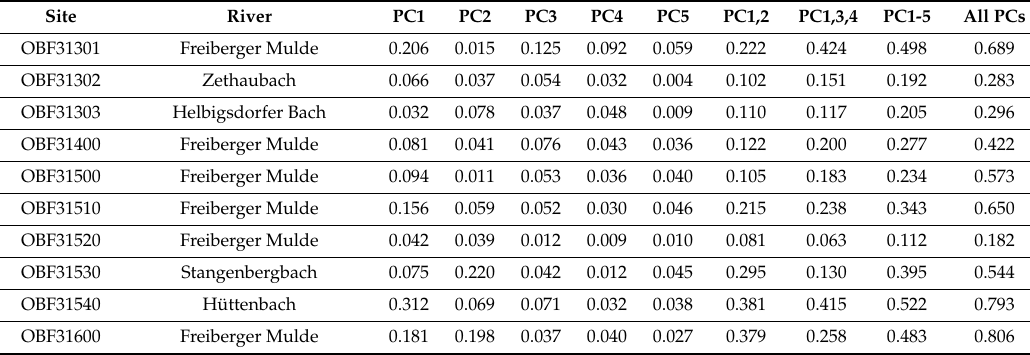
The variance (in percentage) explained by each monitoring site on selected principal